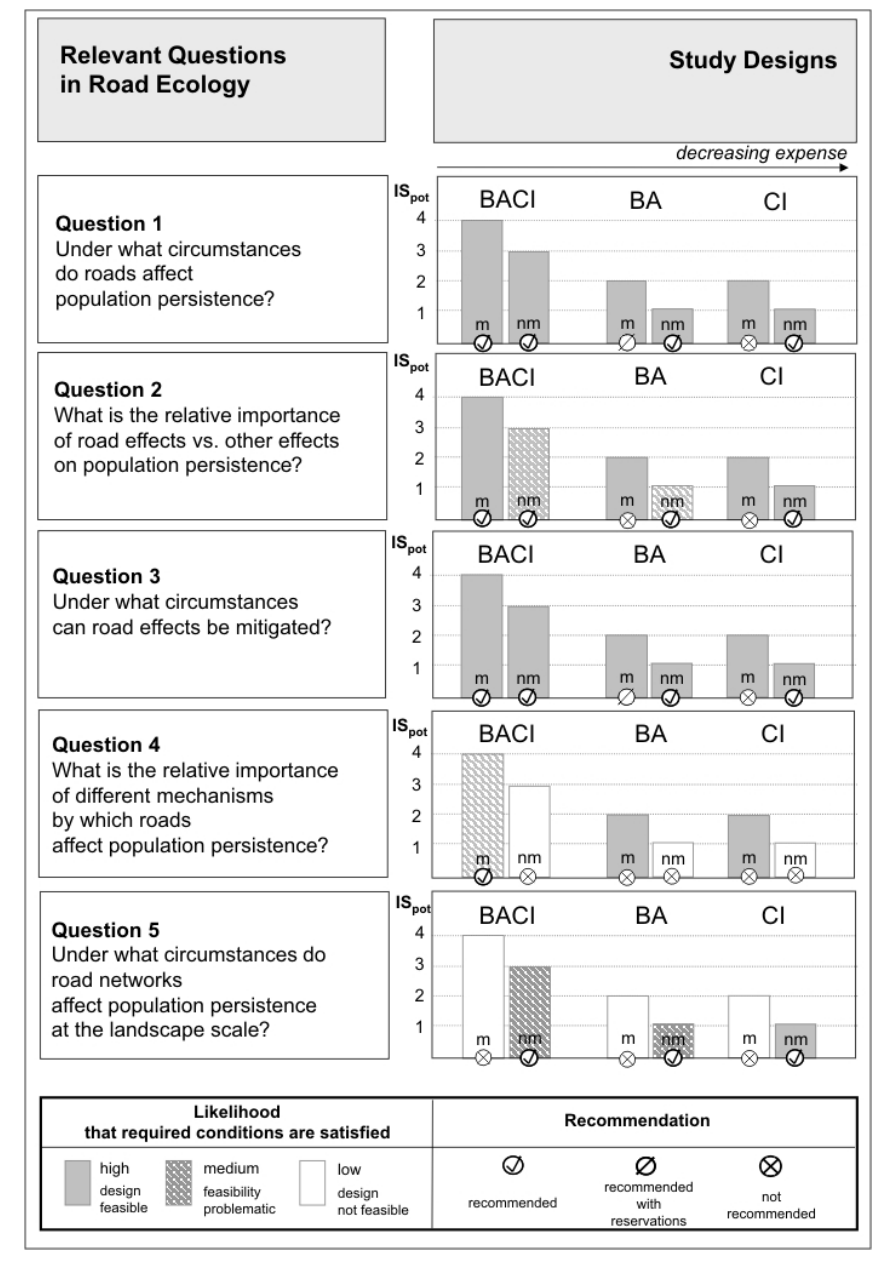
Fig. 1 . The Rauischholzhausen agenda for road ecology: five key questions and potential study designs. There are two study classes, manipulative (m) and nonmanipulative (nm), and three study types: before- after-control-impact (BACI), before-after (BA), and control-impact (CI). Column height indicates inferential strength in ordinal ranks: (1) low, (2) medium, (3) high, and (4) very high. For each design, we provide a qualitative estimate of feasibility in terms of cost, likelihood of required data being available, etc., and a recommendation based on feasibility and inferential